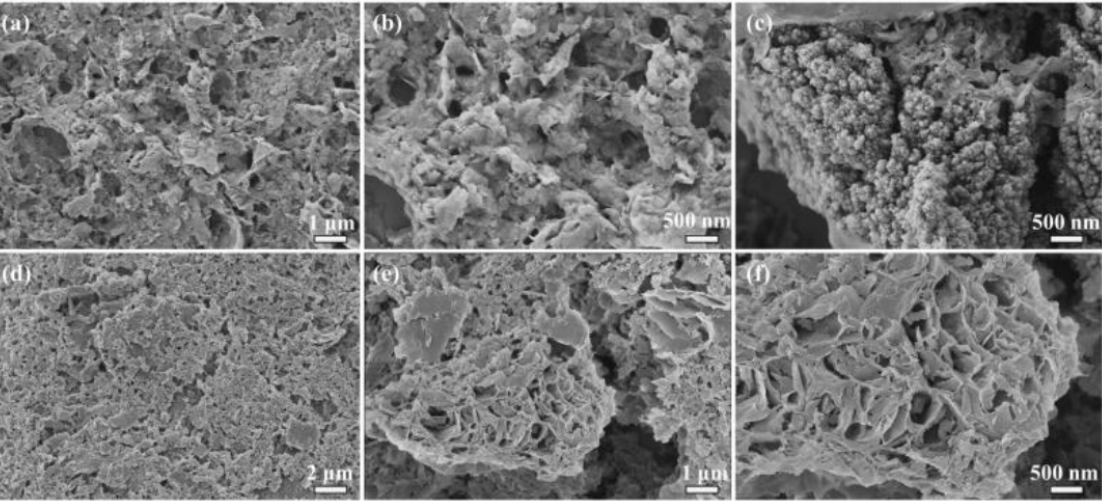
Figure 3. ( a – f ) SEM images of CTS/CA/BT composite hydrogel with different magnifications. Coordinated with the XRD spectra in Figure 4, the diffractogram of CTS/CA/BT composite hydrogel shows the slight displacement of the CTS peaks. However, for BT, the intense peak, initially observed at d = 12.71 Å, which represents the d(001) space in BT, was obviously decreased though this shift did not occur in the spectrum of CTS/CA/BT composite hydrogel, indicating the disintegration of original compact structure to a certain extent and the formation of an exfoliated nanostructure of CTS/CA/BT composite hydrogel caused by the acid and polymer backbones [39]. Thus, the active sites were exposed, which was in favor of the adsorption of heavy metal ions by the CTS/CA/BT composite